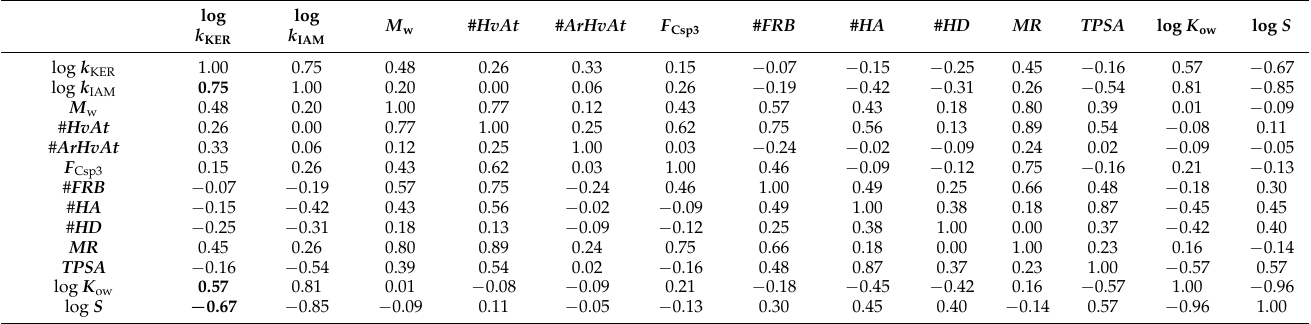
Table 4. Correlations ® between chromatographic and calculated parameters ( n =